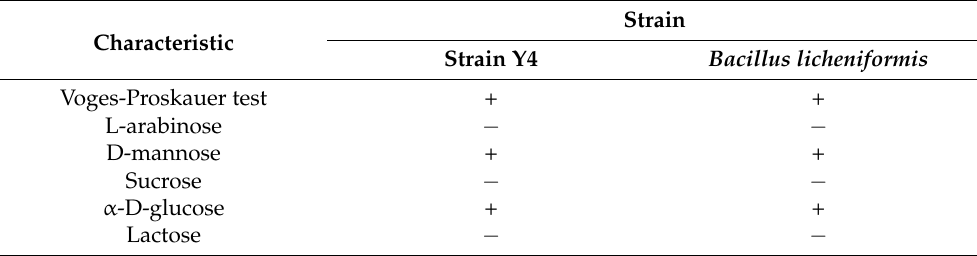
Table 2. Differential characteristics of strain Y4 and Bacillus licheniformis